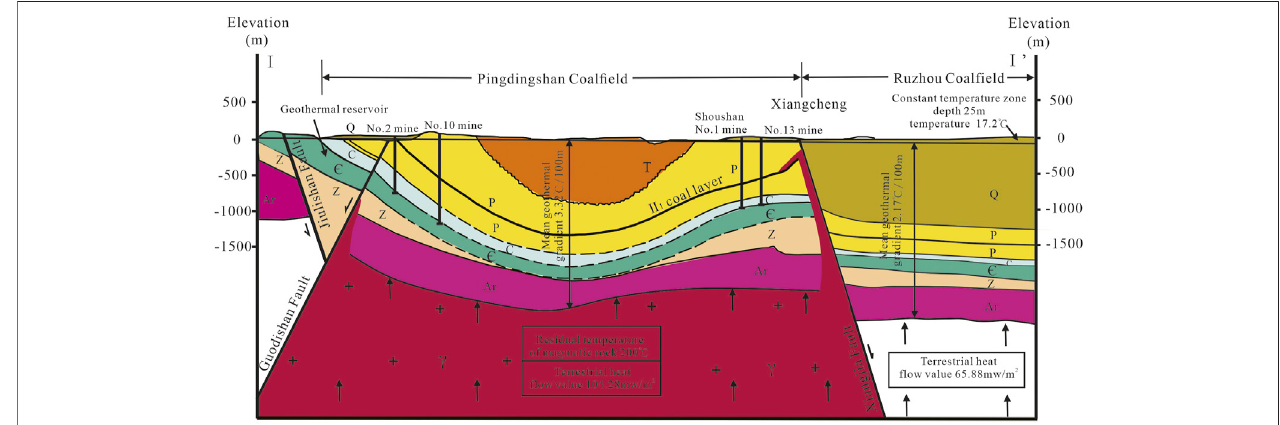
FIGURE 8 | Conceptual model diagram of geothermal